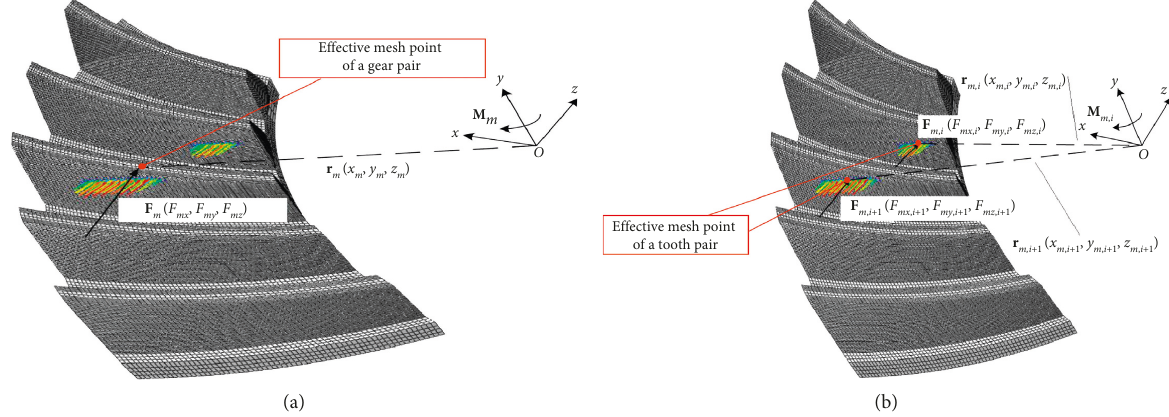
Figure 4: Synthesis of the effective mesh parameters of the (a) single-point coupling mesh model and (b) multipoint coupling mesh